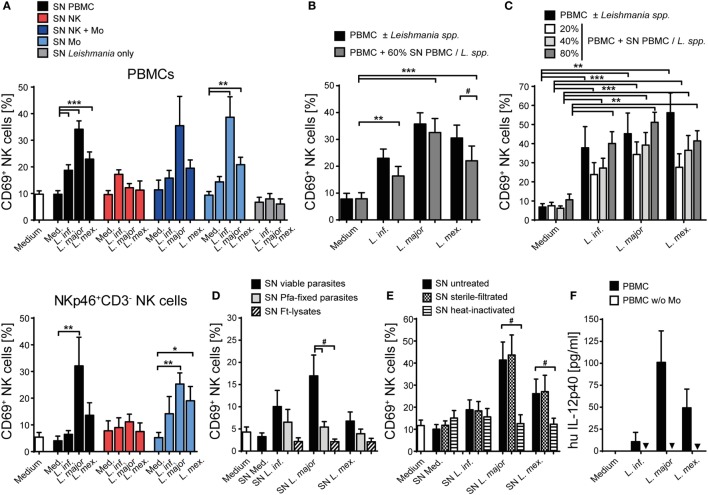
CD69 on natural killer (NK) cells is induced by a heat-labile soluble factor derived from infected monocytes. Human peripheral blood mononuclear cells (PBMCs) [(A) (top panel), (B–E)] or purified NKp46+CD3− NK cells [(A) (bottom panel)] were stimulated with supernatants (SN) of various cell-Leishmania-cocultures for 20 h. CD69 expression of NKp46+CD3− NK cells was determined by flow cytometry. Unless otherwise indicated (C), SNs were added (A,B,D,E) at a final concentration of 60% (vol/vol) and used untreated (A–D), sterile filtered (E), or heat-inactivated (E). [(A) top panel] Mean ± SEM of 59/59/50/49 (SN PBMC), 4/3/4/3 (SN NK), 4/4/4/2 (SN NK + Mo), 4/4/4/4 (SN Mo), or 8/8/6 donors (SN Leishmania only). [(A) bottom panel] Mean ± SEM of 7/7/6/5 (SN PBMC), 3/3/2/3 (SN NK), or 6/6/6/6 (SN Mo) donors for the four stimulations. (B) Mean ± SEM of 24/23/20/15 donors for the four stimulations. (C) Mean ± SEM of 11/4/3/4 (Leishmania spp.), 9/9/7/8 (20% SN), 10/11/7/7 (40% SN), or 9/9/7/9 (80% SN) donors for the four stimulations. (D) Mean ± SEM of seven (SN viable), seven (SN pfa-fixed), and four [SN freeze–thaw lysate (ft-lysate)] donors. (E) Mean ± SEM of 10/10/8/10 (SN untreated), 9/9/7/9 (SN filtered), and 9/9/6/8 (SN heat-inactivated) donors for the four stimulations. (F) PBMCs or PBMCs depleted of monocytes were cocultured with Leishmania spp. promastigotes (multiplicity of infection 10) for 20 h. The concentration of interleukin (IL)-12p40 in culture SNs was determined by ELISA (values below detection limit are marked by triangles). Mean ± SEM of 6/6/5/5 (PBMC) and 6/5/5/6 (PBMC w/o monocytes) donors for the four stimulations. *,#p < 0.05, **p < 0.01, and ***p < 0.001 two-tailed Mann–Whitney U test.